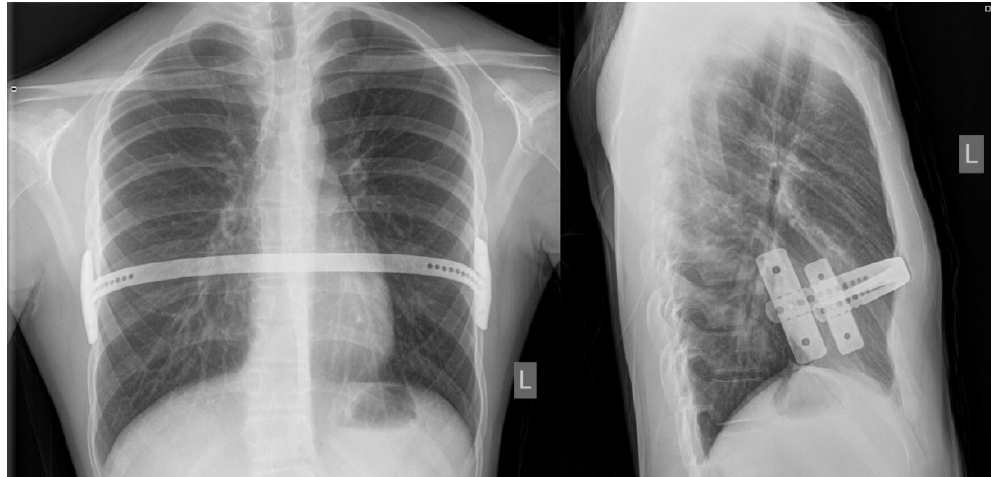
Figure 3. Bar position at postoperative chest X-ray: posteroanterior ( left ) and laterolateral ( right ) views.